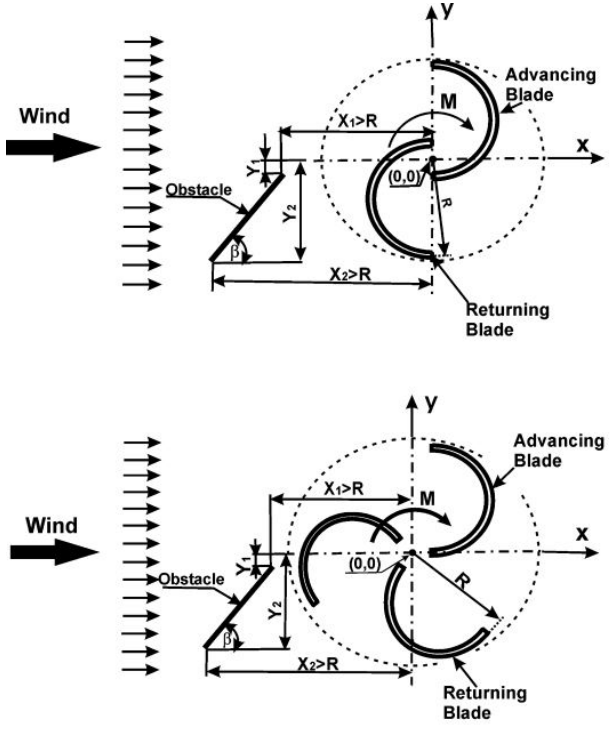
Figure 8. Power coefficient optimization of two-bladed and three-bladed Savonius turbine with flat-plate deflector (adapted from [77]).